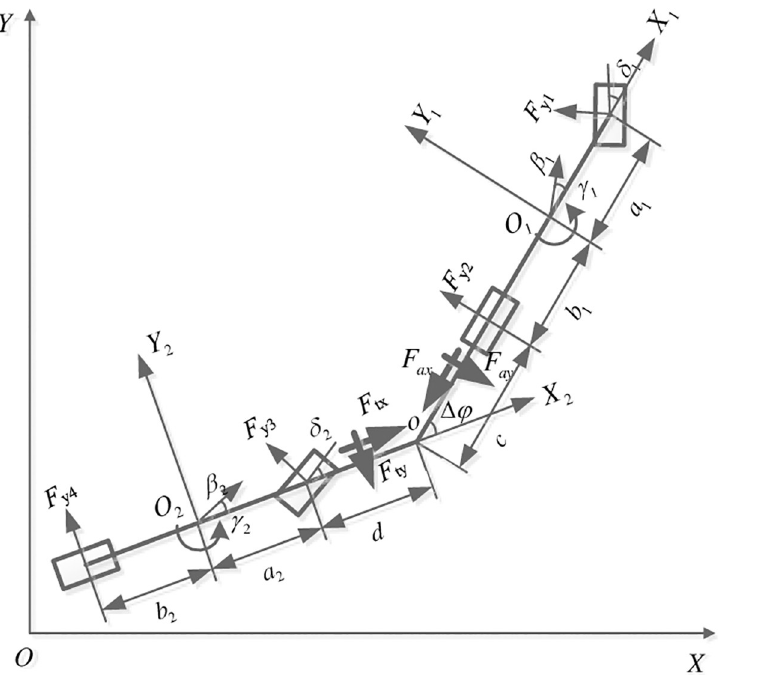
Fig 1. Dynamics model of